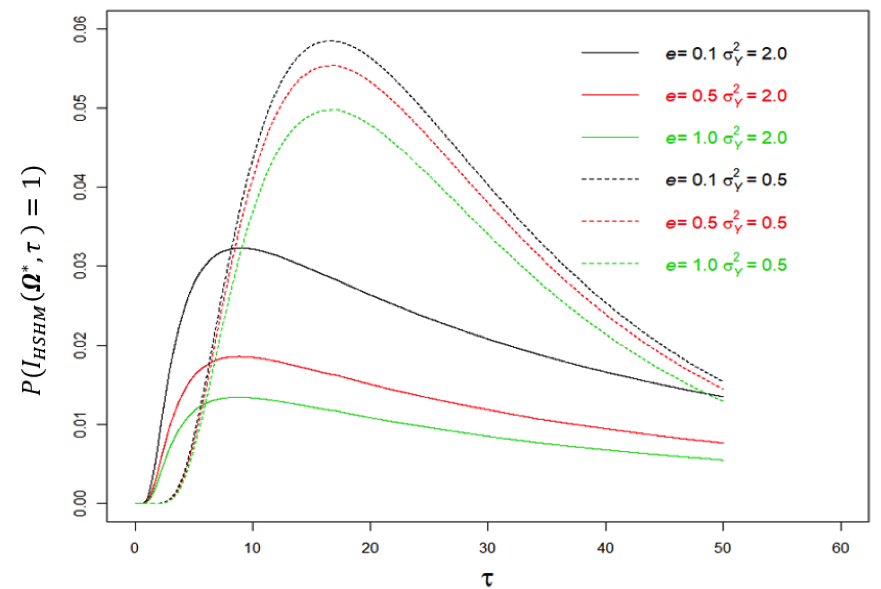
Figure 5. Dependence of P(I HSHM ((cid:127) ∗ ,τ) = 1 ) on ( τ ) and on anisotropy ratio e . Solid and dashed lines represent, respectively, the proba- = 2 . 0) and small ( σ 2 = 0 . 5) variance of the log-hydraulic bilities of large ( σ 2 Y Y